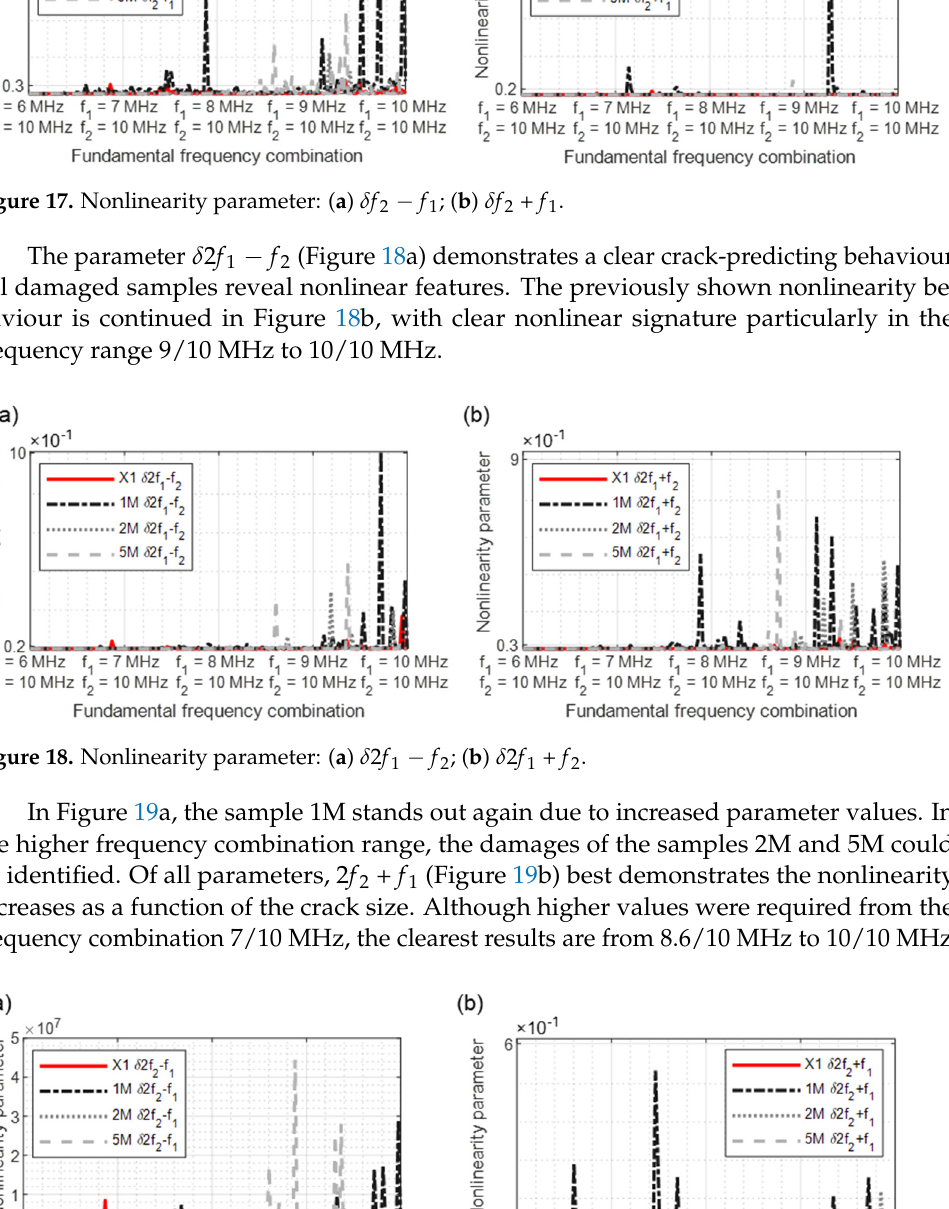
Figure 17. Nonlinearity parameter: ( a ) δ f 2 − f 1 ; ( b ) δ f 2 +f 1 .